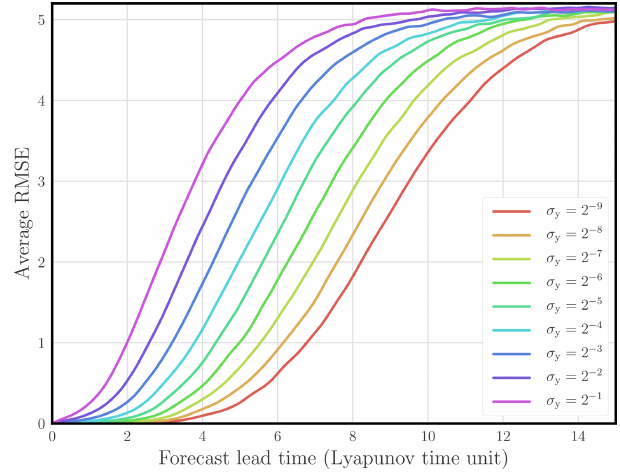
Figure 6. Coefficients of the surrogate PDE model (blue) result- ing from the expansion of the surrogate ODEs and compared to the reference PDE’s coefficients (orange).